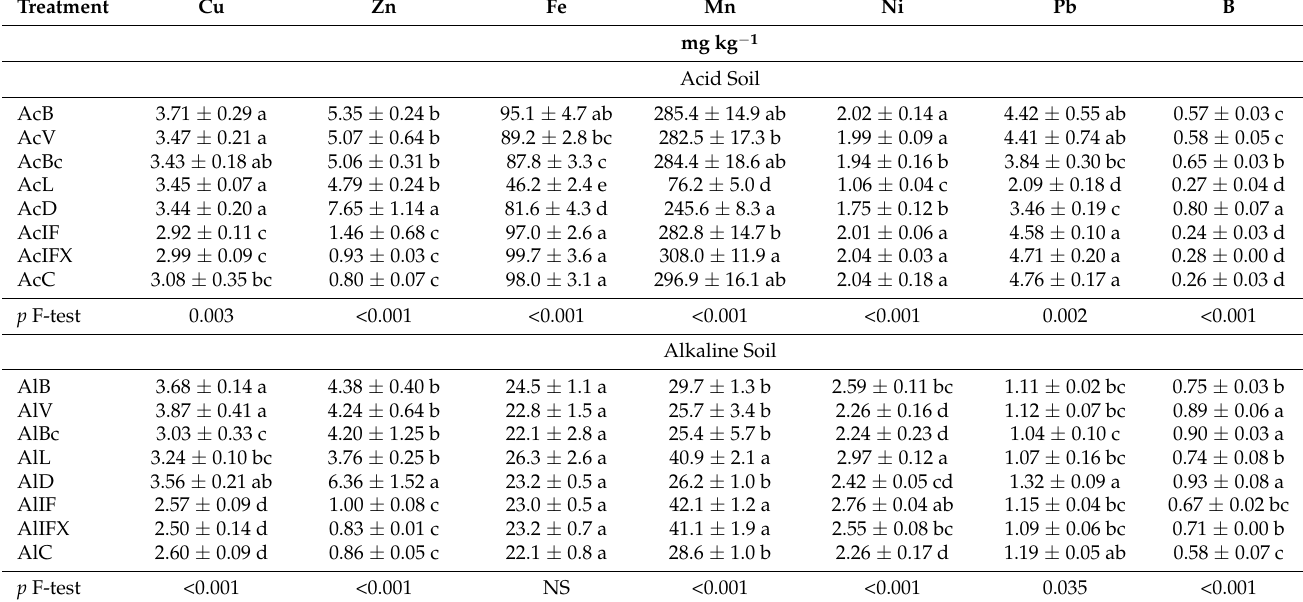
Table 4. Concentrations of available micronutrients and heavy metals of soil treatments before the pot experiment with white clover. Available Cr, Cd and Hg were not detectable. NS: non-significant. Treatment of the acid and alkaline soil, respectively, with: AcB and AlB: bentonite-treated sludge; AcV and AlV: vermiculite-treated sludge; AcBc and AlBc: biochar-treated sludge; AcL and AlL: limed sludge; AcD and AlD: air-dried sludge; AcIF and AlIF: N-P-K inorganic fertilization; AcIFX and AlIFX: P-K inorganic fertilization; AcC and AlC: control. Different letters, within each soil and property, indicate significant differences among means, using the LSD test, at p ≤